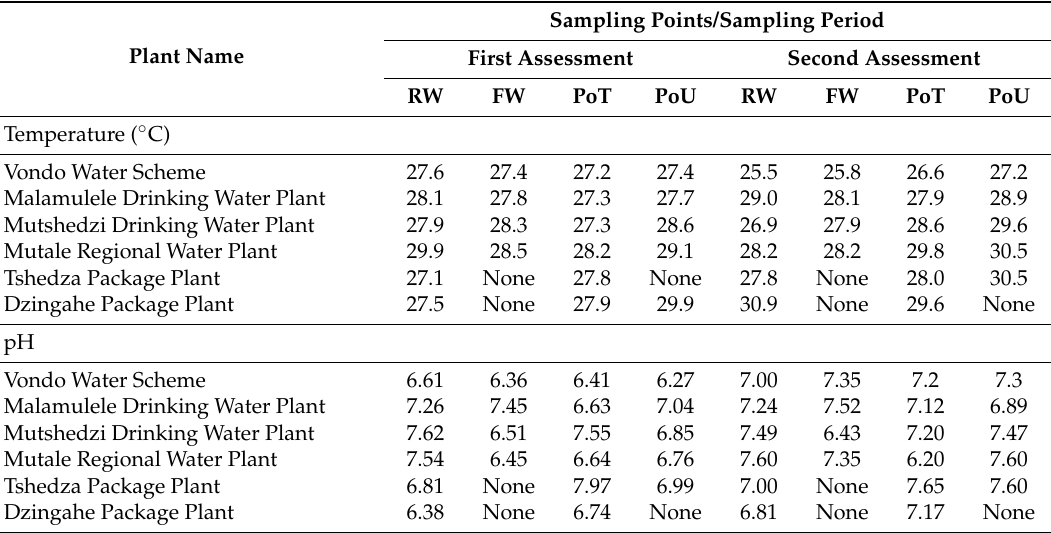
Table 5. Monitoring of temperature and pH in selected